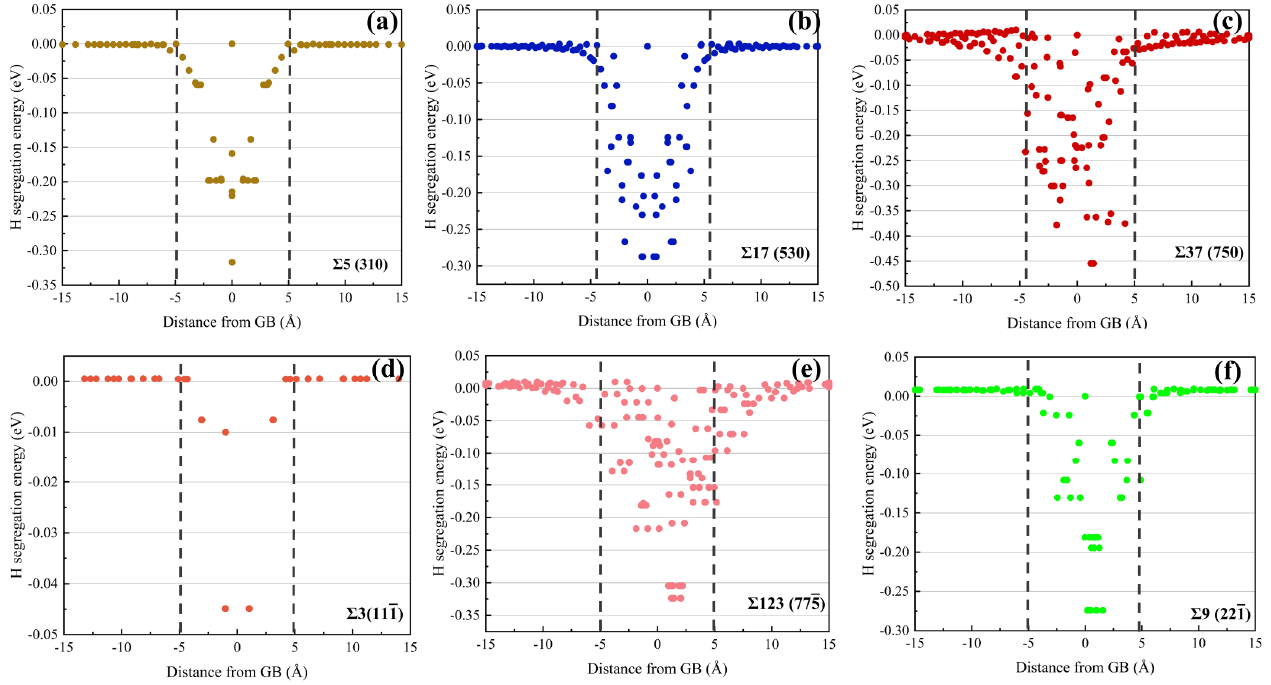
Figure 5. Hydrogen segregation energy distribution as a function of GB distance for ( a – c ) < 001 > and ( d – f ) < 11(cid:3364)0 > STGBs.